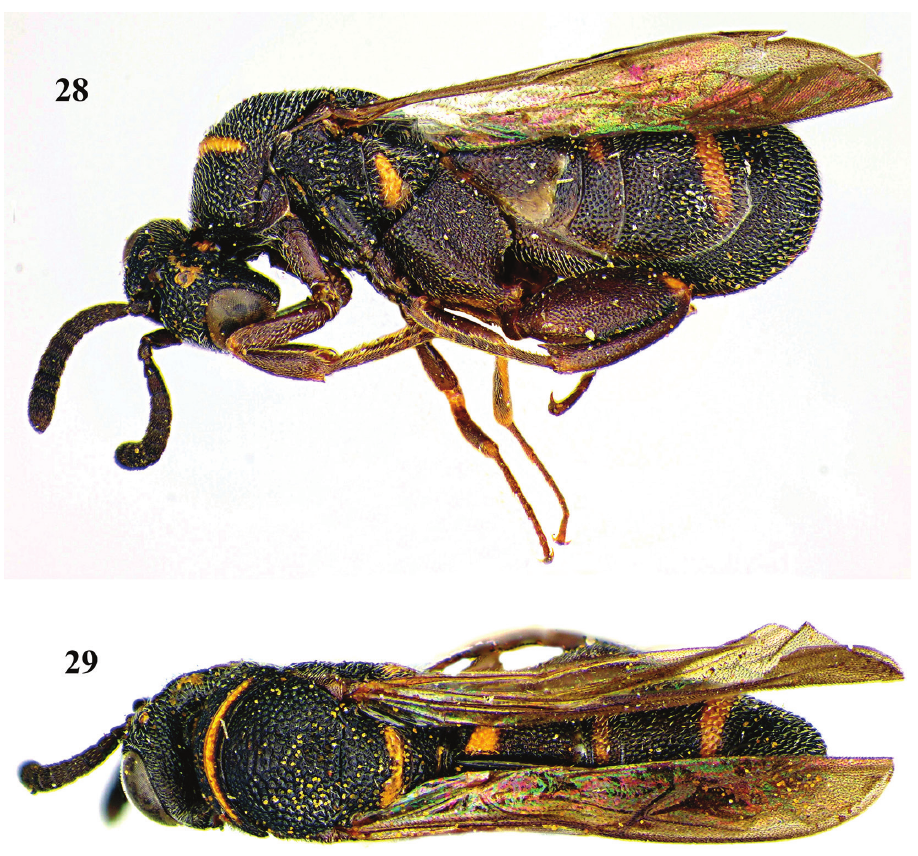
Figures 28, 29. Leucospis yasumatsui Habu, ♀ , holotype. 28 Habitus lateral 29 habitus dorsal (courtesy of Dr. Toshiharu Mita, Kyushu